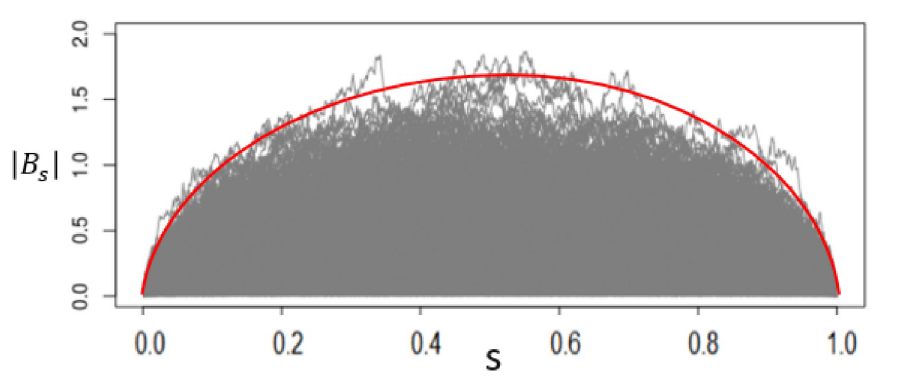
Fig 3. Control limit of | B s |.